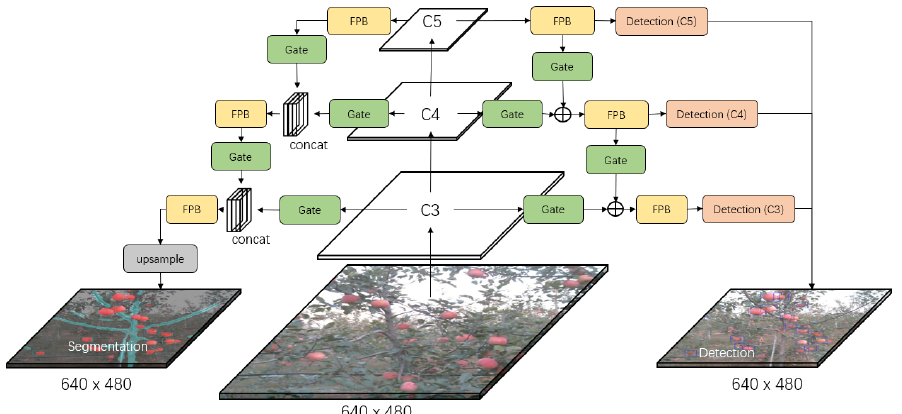
Figure 3. The architecture of DaSNet-B model. DaSNet-B has the common GFPN but the independent feature processing block for processing of detection and segmentation tasks. FPB-s stands for the feature processing block of the segmentation branch, while FPB-d stands for the feature processing block of the detection branch.